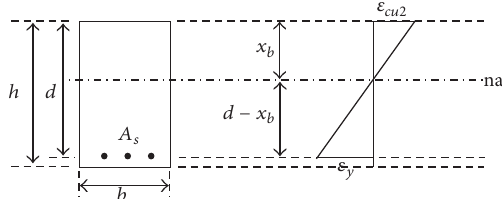
Figure 5: Stress-strain relationship, RILEM [15].